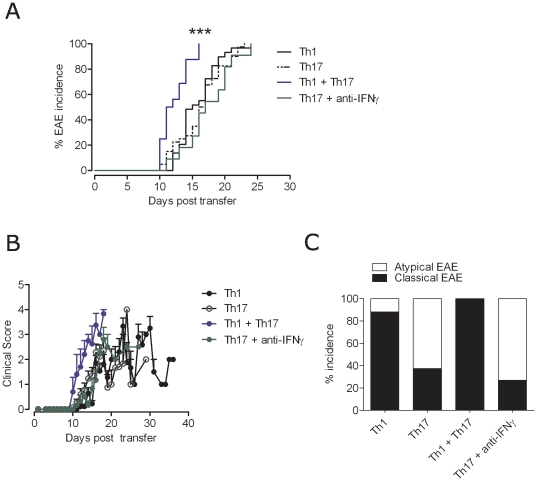
Adoptive transfer EAE with polarized Th1 and Th17 cells.Th1 and Th17 polarized cells were adoptively transferred to Rag2−/− recipient mice, either alone or in combination or with anti-IFN-γ treatment as indicated. Recipient mice were scored for EAE disease. A. Shown is the percentage of EAE incidence in the different recipient mice. ***p<0.0001; Th1+Th17 vs. all other conditions. B. EAE clinical scores in the different recipient mice. Data is represented as mean ± SD. C. Incidence of classical and atypical EAE phenotype in different T cell transfers. Shown is the percentage of classical vs. atypical EAE incidence in the different recipient mice. Th1: n = 29; Th17: n = 40; Th1+Th17: n = 16; Th17+ anti-IFN-γ: n = 11.